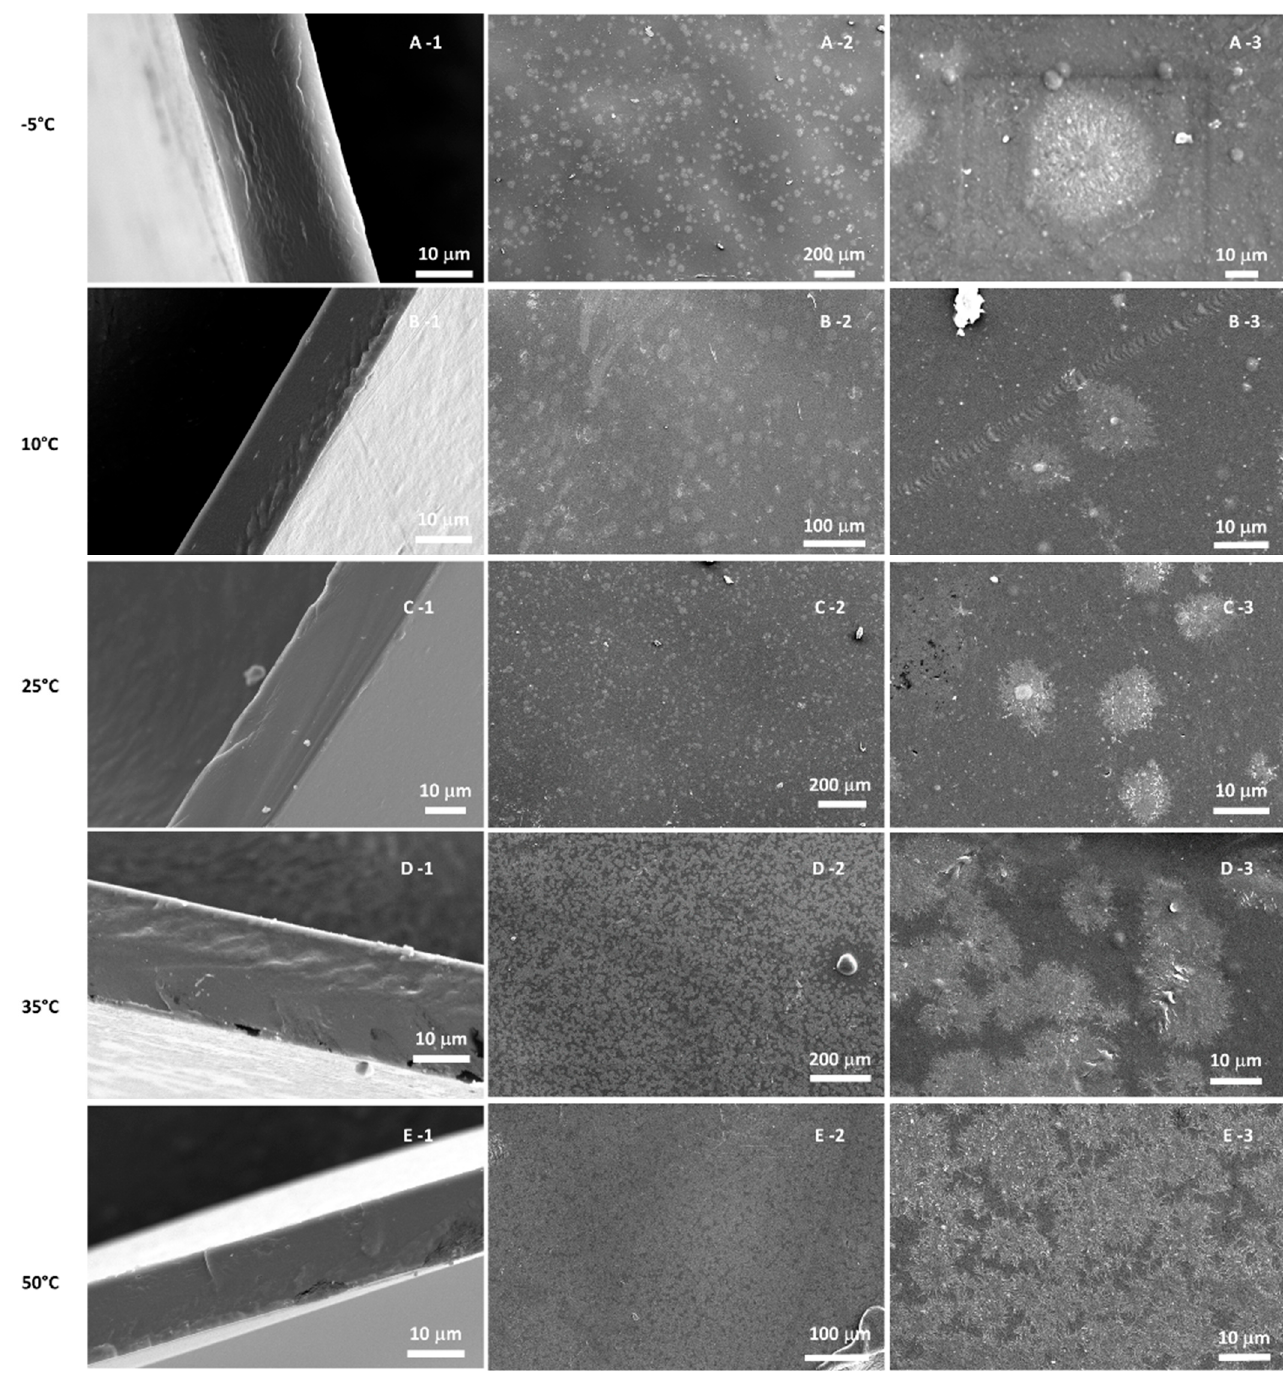
Figure 4. SEM cross sectional (-1) and surface (-2, -3) images from PEBAX cast at different tempera- tures (A: − 5 °C, B: 10 °C, C: 25 °C, D: 35 °C, E: 50 °C).